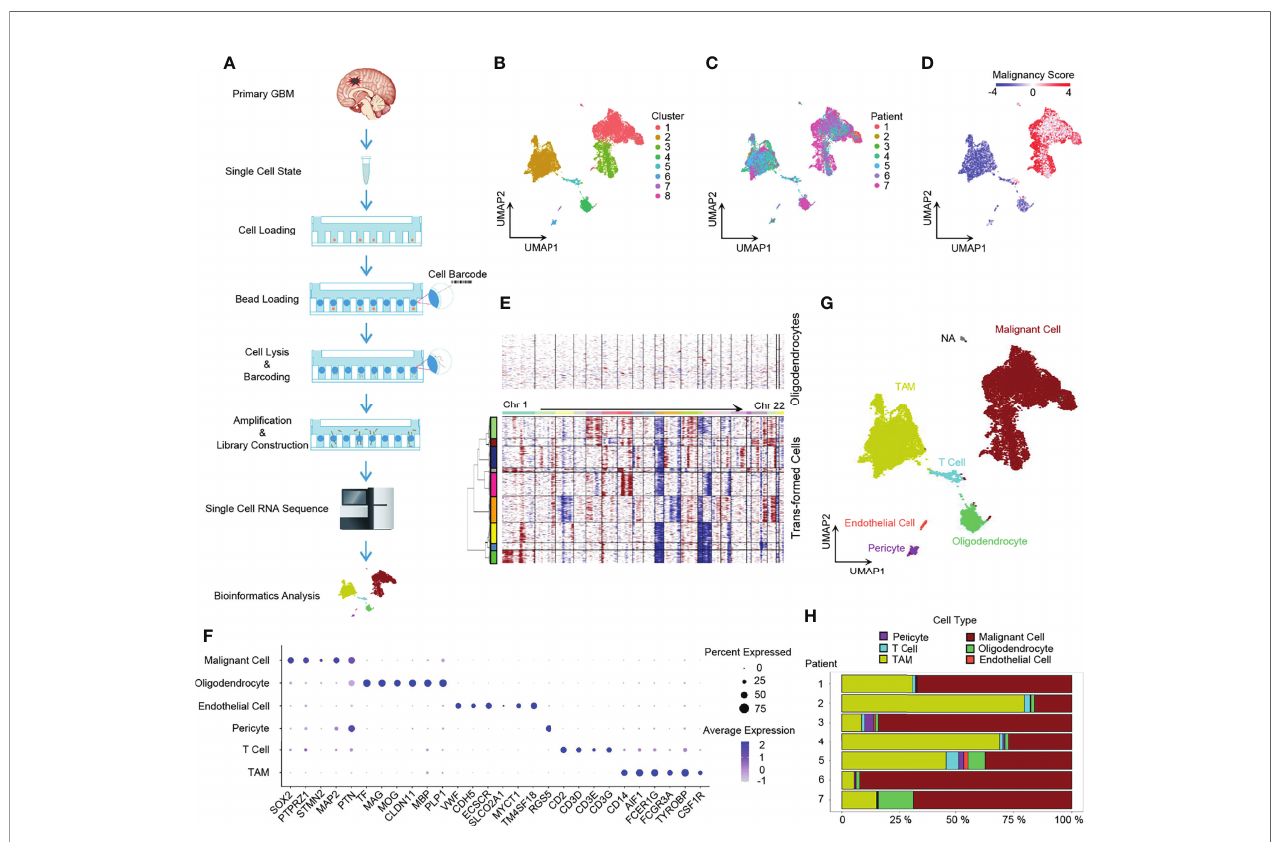
FIGURE 1 | Dissection of primary GBM by scRNA-seq. (A) Scheme of the work fl ow in our study. (B) UMAP projection of all 20,289 GBM cells including tumor cells and stromal cells. Eight clusters were found when index Resolution in Seurat FindClusters was set as 0.05. (C) UMAP visualization showing cells of individuals. (D) UMAP of malignancy scores. Transformed cells had higher malignancy scores and were colored with red, while non-tumor cells had lower malignancy scores and were in blue. (E) Evaluation of copy number variations (CNVs). Compared to oligodendrocytes, malignant cells presented with obvious CNVs. Red, ampli fi cation; blue, deletion. (F) Dot plot of cell marker gene expression level. (G) Annotation of cell types in GBM. The majority of GBM cells were malignant cells and TAMs, and GBM still had a small number of normal oligodendrocytes, endothelial cells, pericytes, and T cells. (H) Composition ratio of cell types in individual GBM. See also Supplementary Figure 1